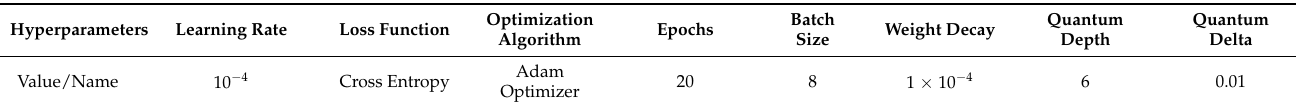
Table 3. Hyperparameters of the classical–quantum neural network.